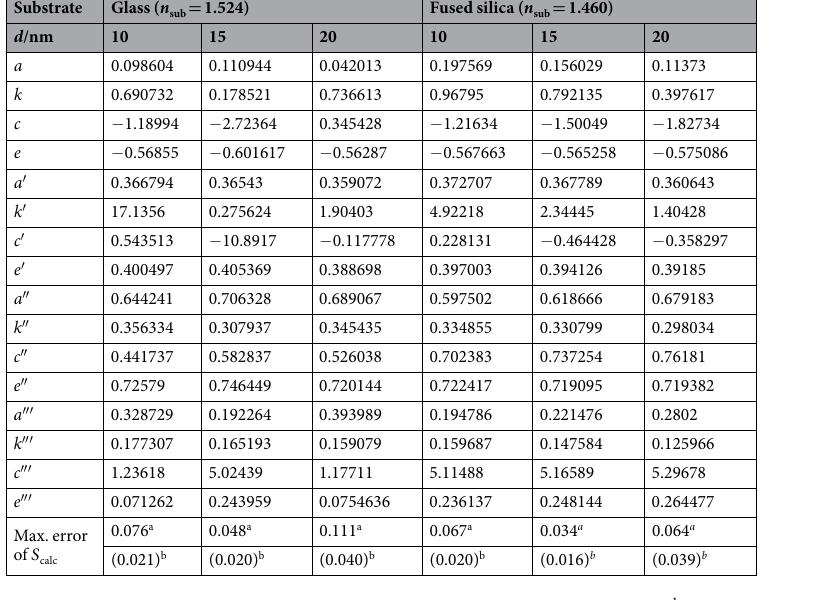
Table 1. All parameters for S calc and their error from S sim . a 1.6 ≤ n org ≤ 2.2, b 1.6 ≤ n org ≤